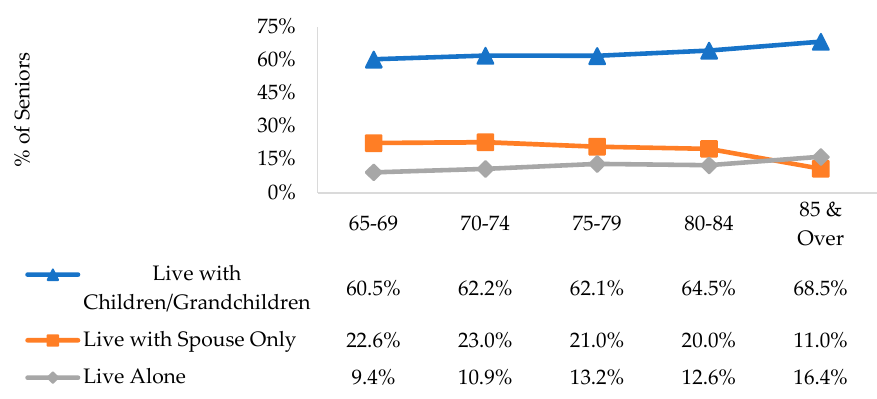
Figure B. Age-Specific Proportion of seniors by Living Arrangements in 2014. 187